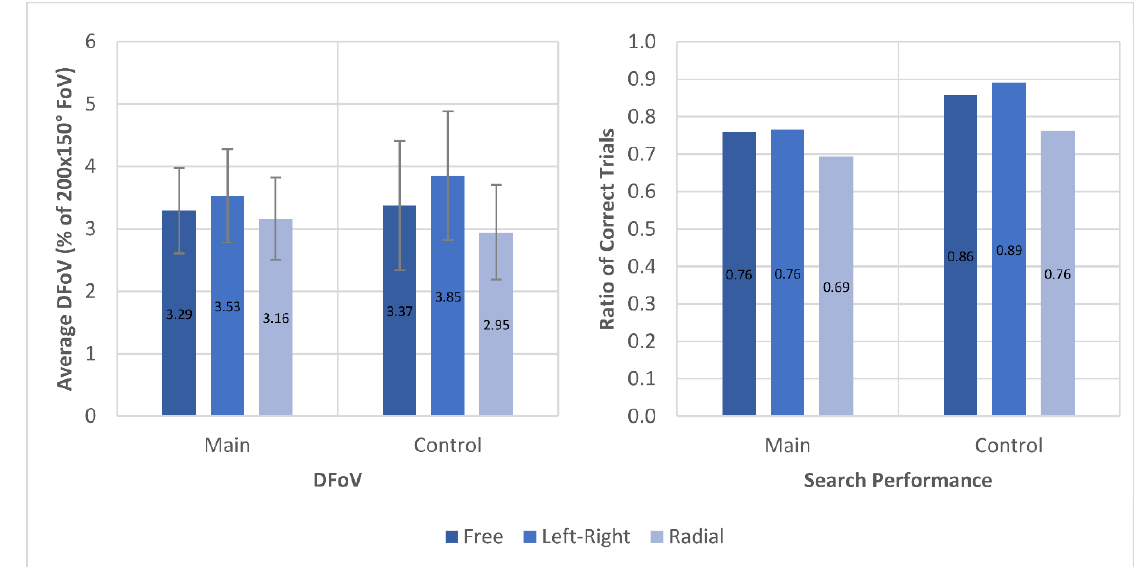
Figure 7. Comparison of average DFoV and ratio of trials in which the correct number of targets were found between the three different scanning pattern conditions during search task for both main group and control group.